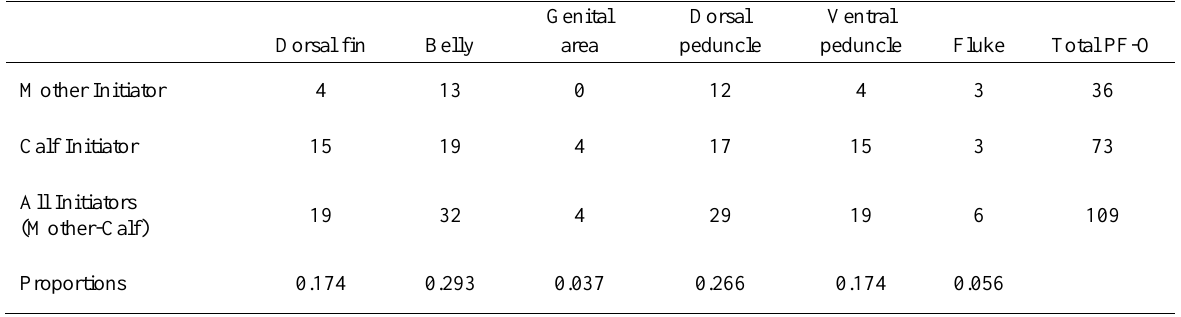
Frequency of Contacts for Body Parts Included in the PF-O Section from Mother-initiated and Calf-initiated Contacts Genital Dorsal fin Belly area